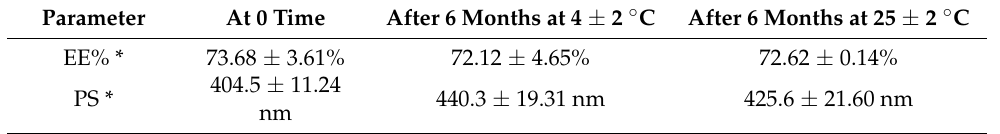
Table 3. Effect of storage on the selected NVH-loaded